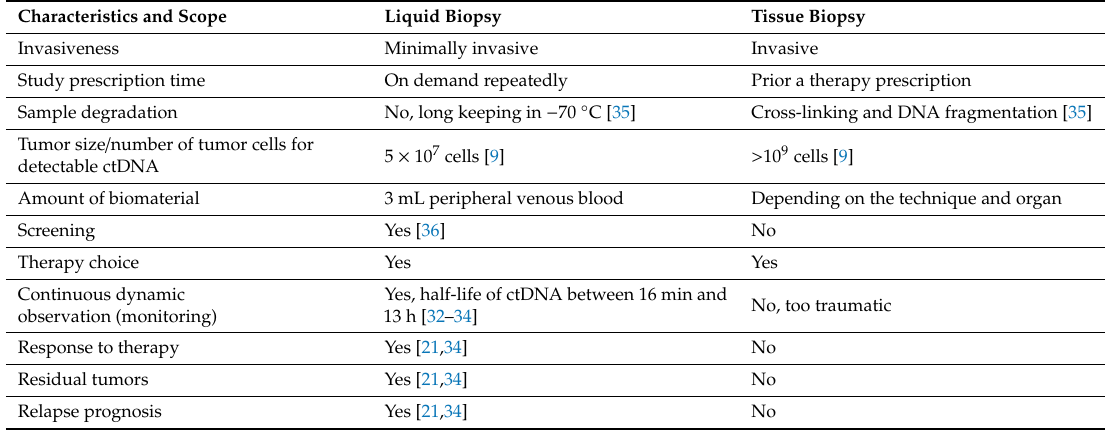
Table 1. Liquid biopsy versus tissue